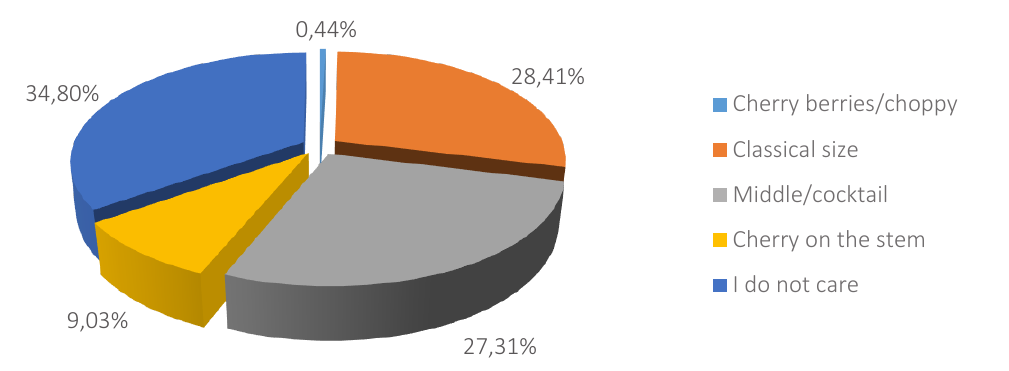
Figure 3. Types of most purchased tomato by generation Z